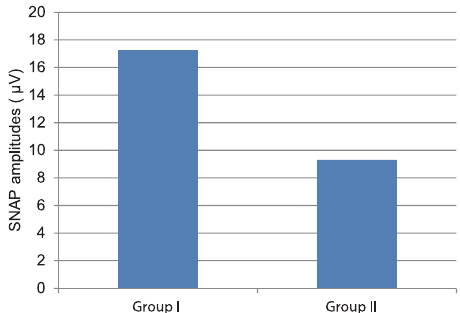
FIGURE 2. Sensory nerve action potential amplitudes. Me- dian value SNAP amplitudes Group I was 17.25 μ V, and for the Group II 9.30 μ V. The difference was statistically signi fi - cant